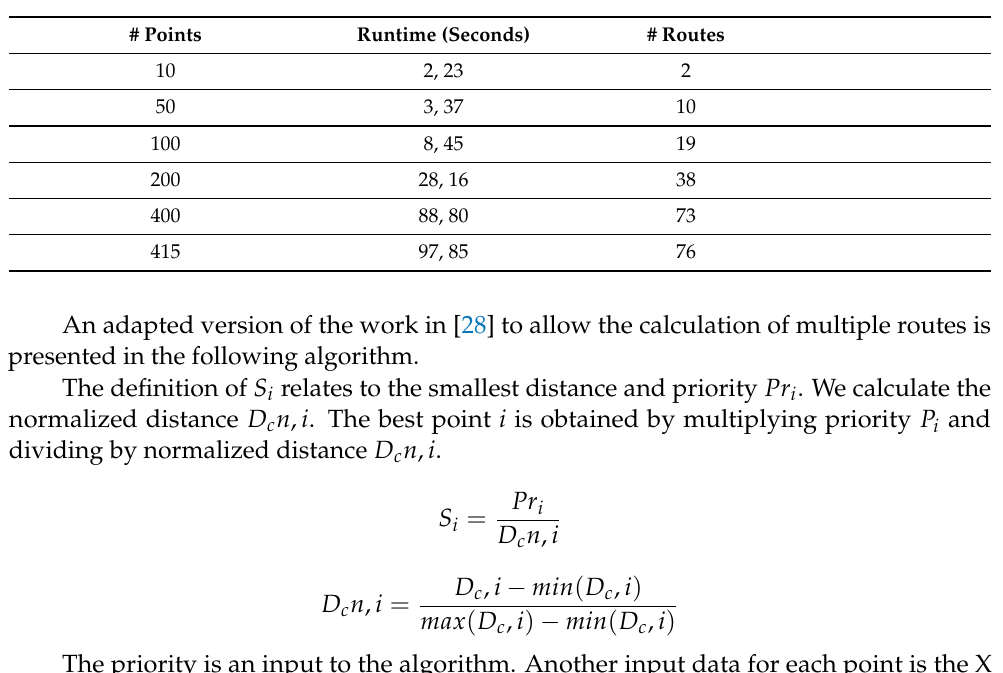
Table 7. Number of points, runtime, and number of